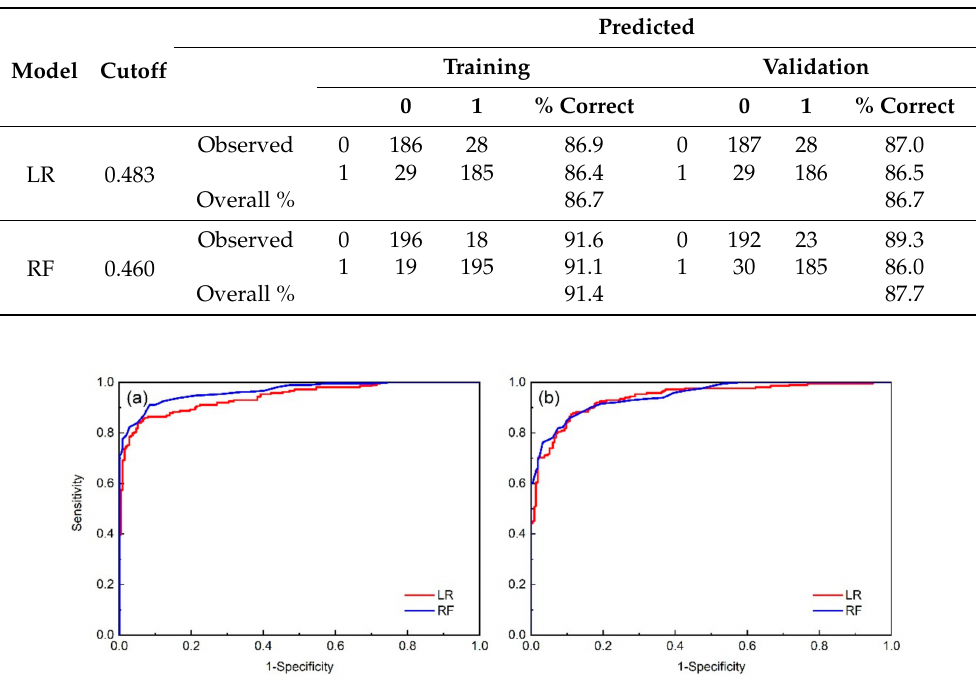
Figure 4. Receiver operating curve (ROC) for LR and RF models: ( a ) training data set, ( b ) validation data